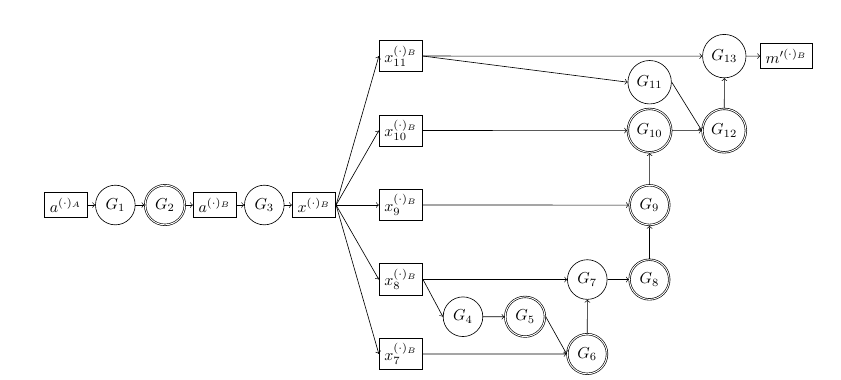
Figure 2: The gadgets considered in the proof of Theorem 1. t -NI gadgets are depicted with a single circle, t -SNI gadgets are depicted with a double